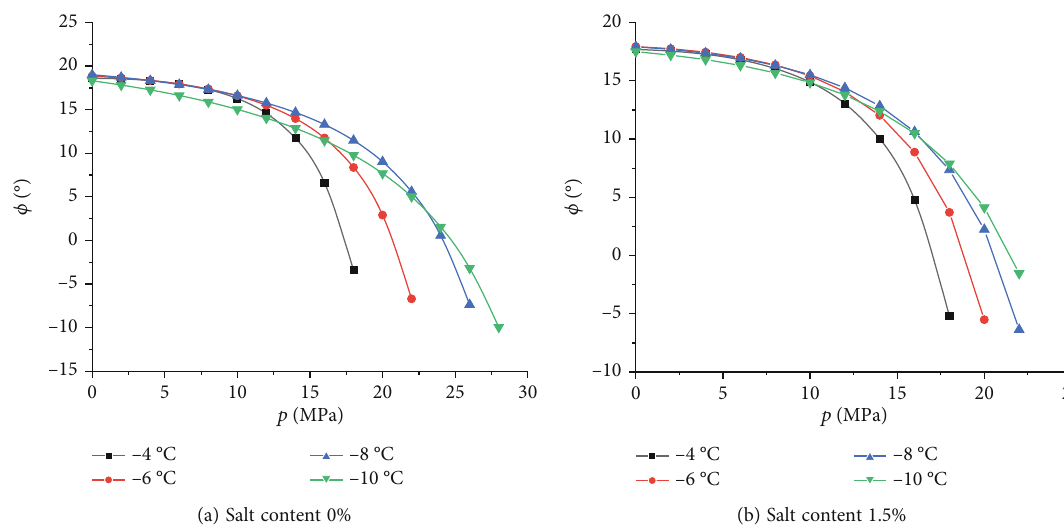
Figure 6: Relationship between average mean principal stress p and internal friction angle ϕ for frozen saline soil at di ff erent